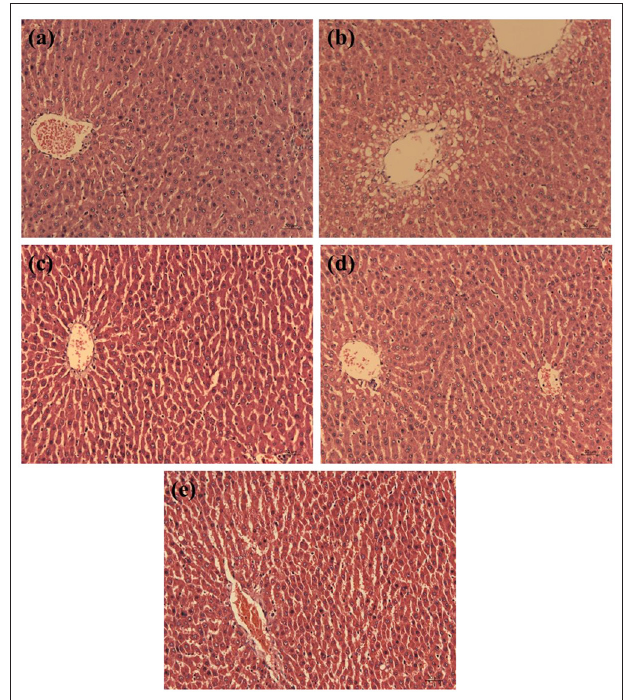
FIGURE 5 | Effect of walnut protein and its hydrolysate on liver histology in D-galactose-treated rats. (a) Control group; (b) D- galactose group; (c) Walnut protein of low dose group; (d) Walnut protein of high dose group; (e) Walnut protein hydrolysate